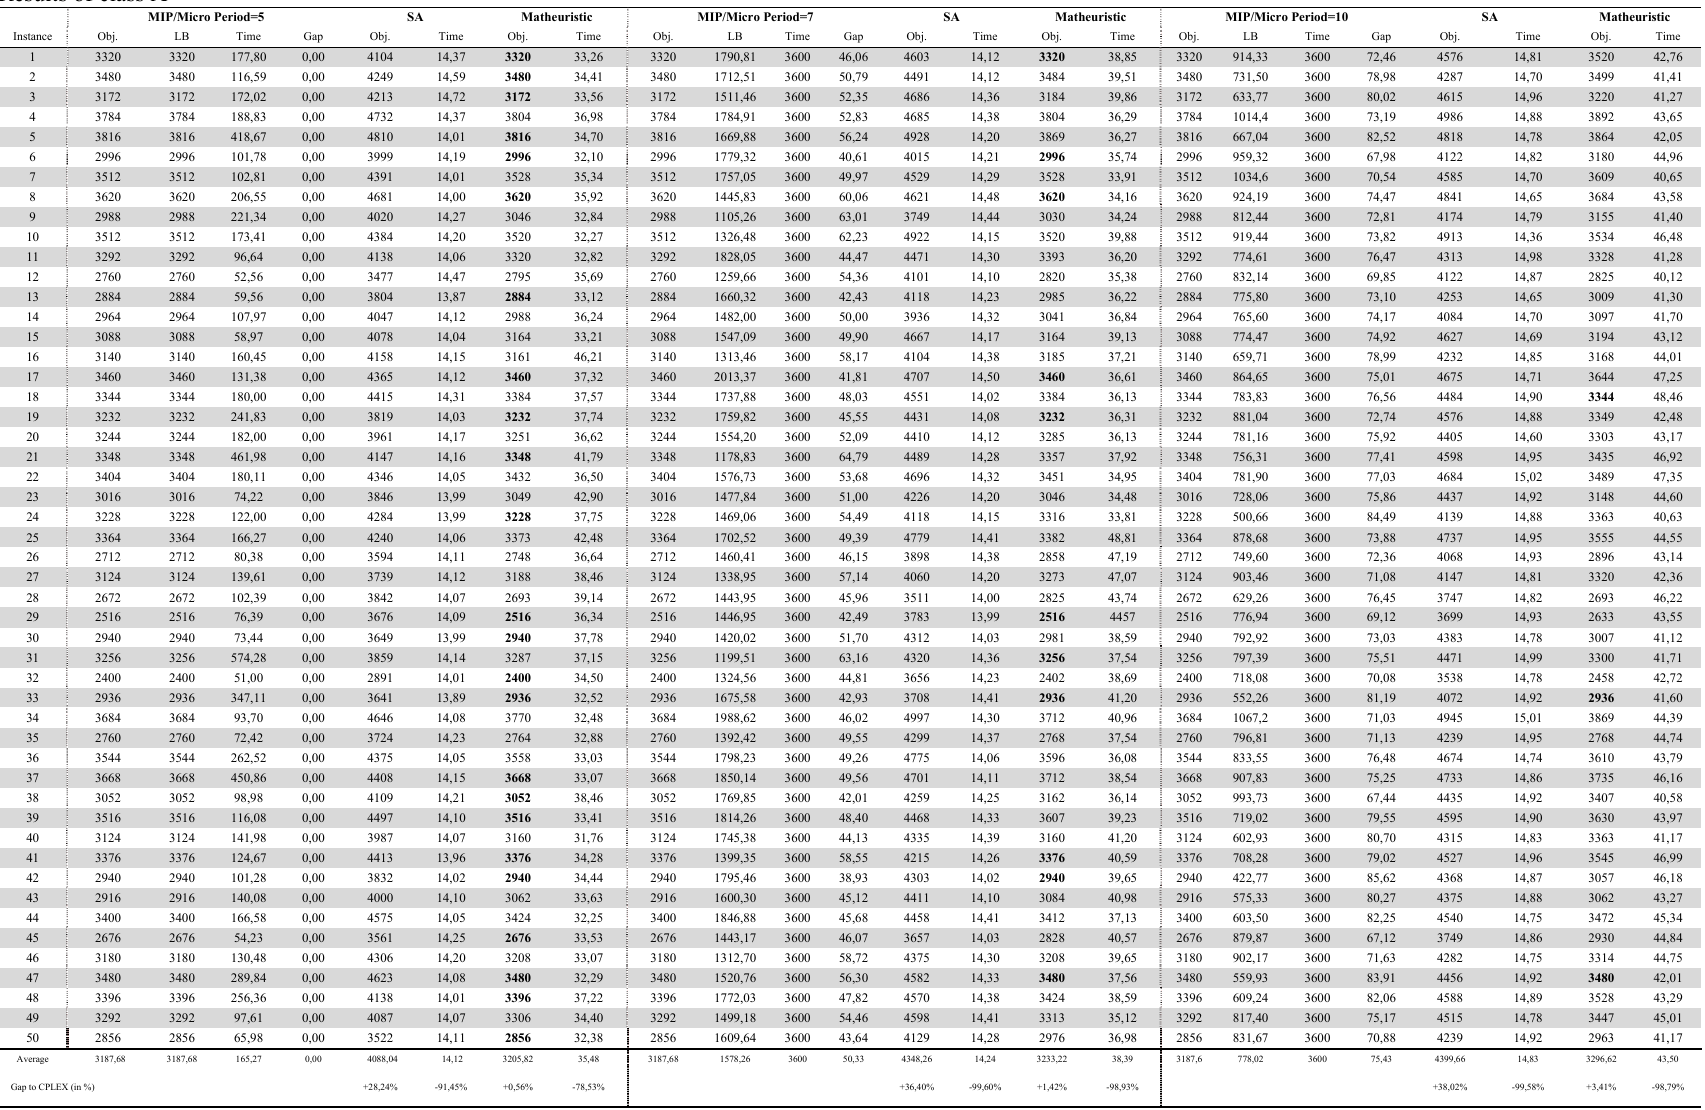
Results of class A